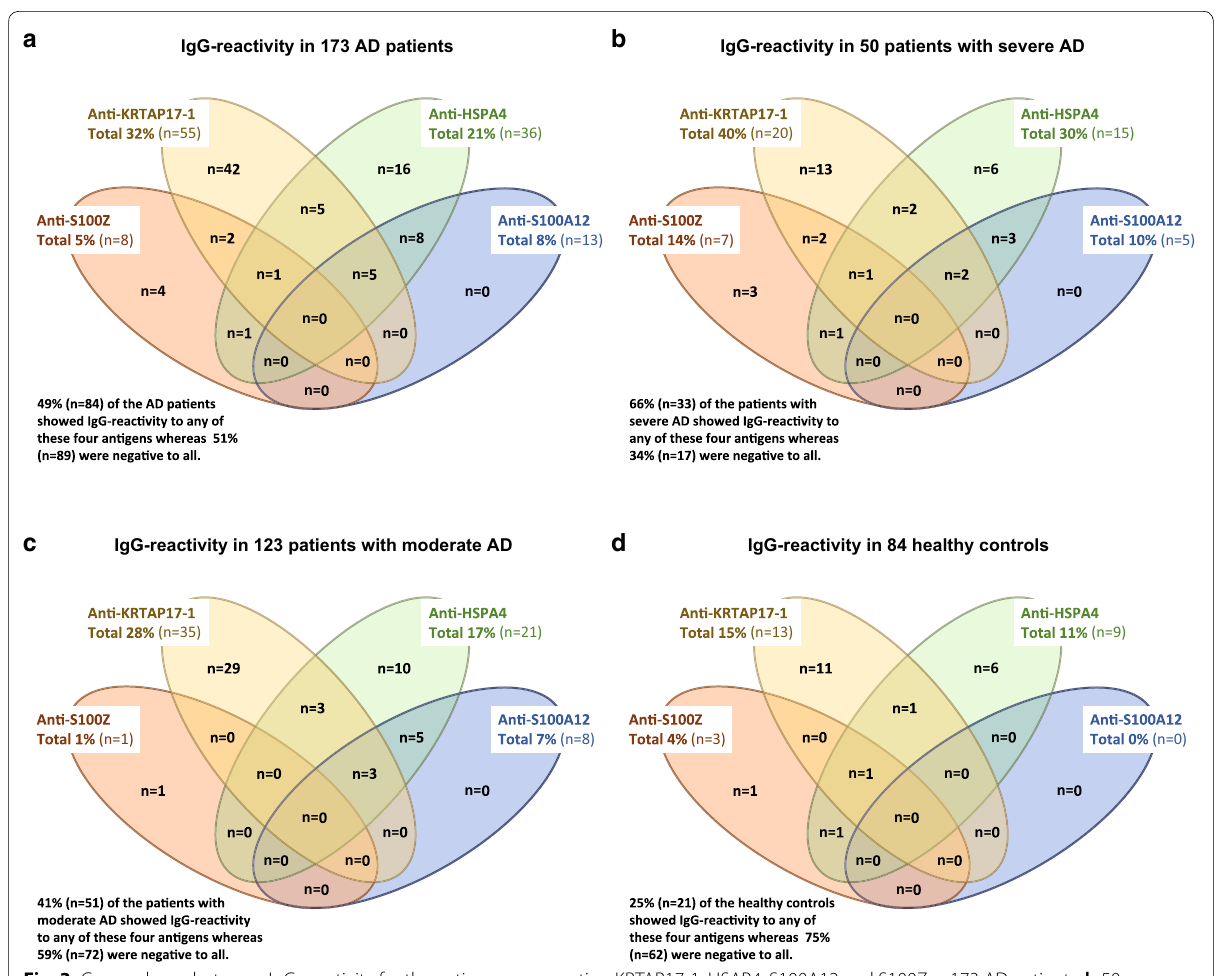
Fig. 3 Concordance between IgG-reactivity for the antigens representing KRTAP17-1, HSAP4, S100A12 and S100Z. a 173 AD patients, b 50 severe AD patients, c 123 moderate AD patients, and d 84 healthy controls. IgG-reactivity based on analysis of the complete cohort using targeted antigen bead arrays. AD atopic